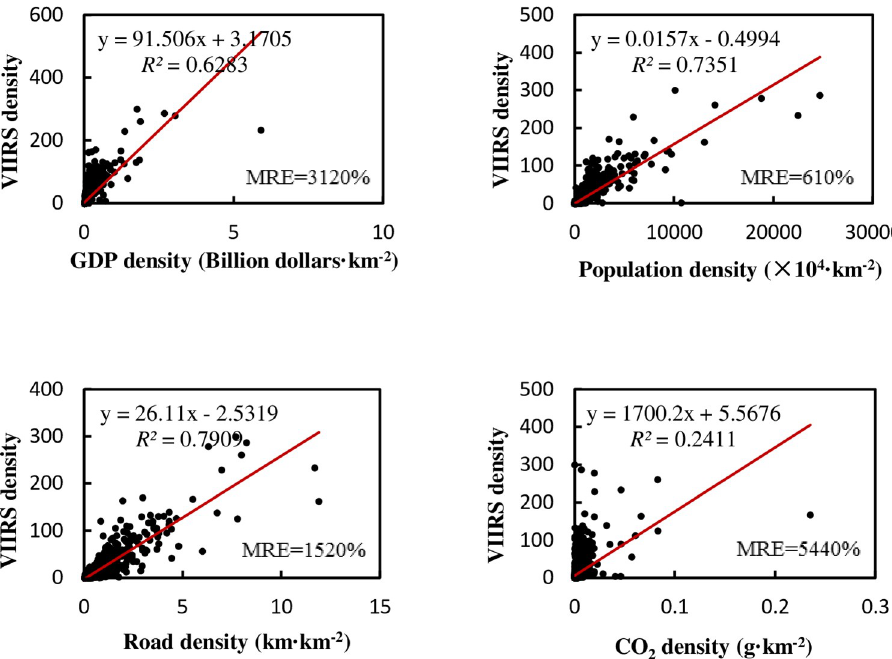
Fig 10. Relationship between NTL density and density of various elements in county-level administrative regions of China.